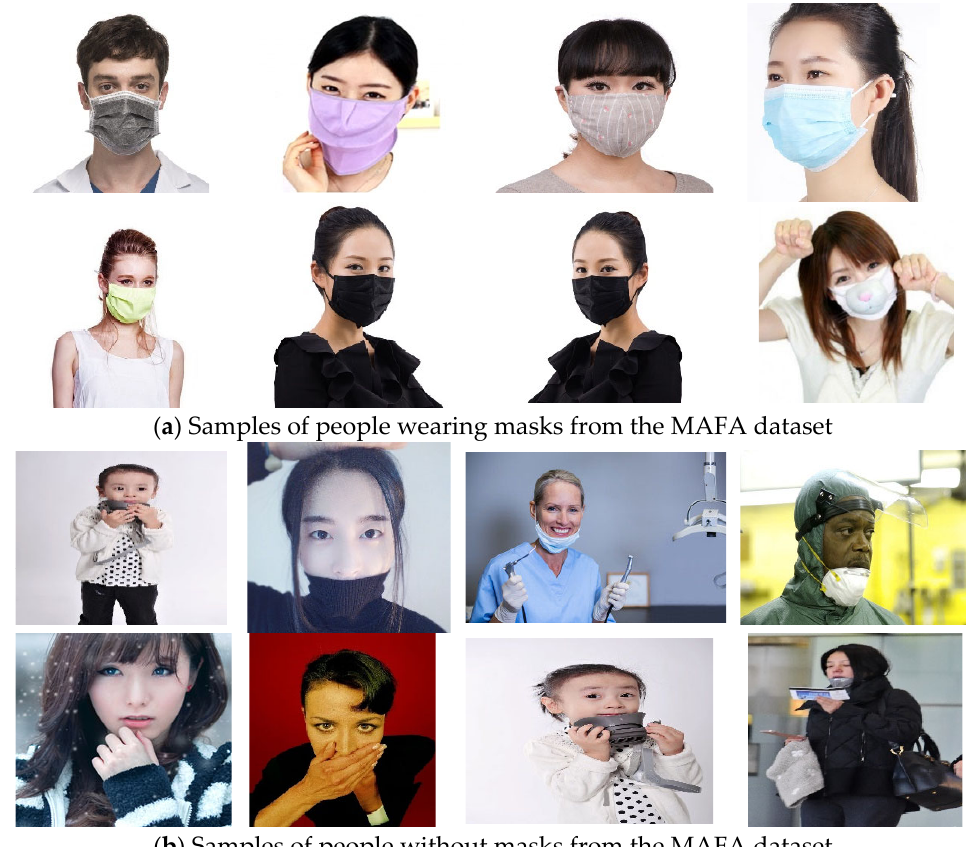
Figure 2. Face mask dataset, samples for each class from the MAFA